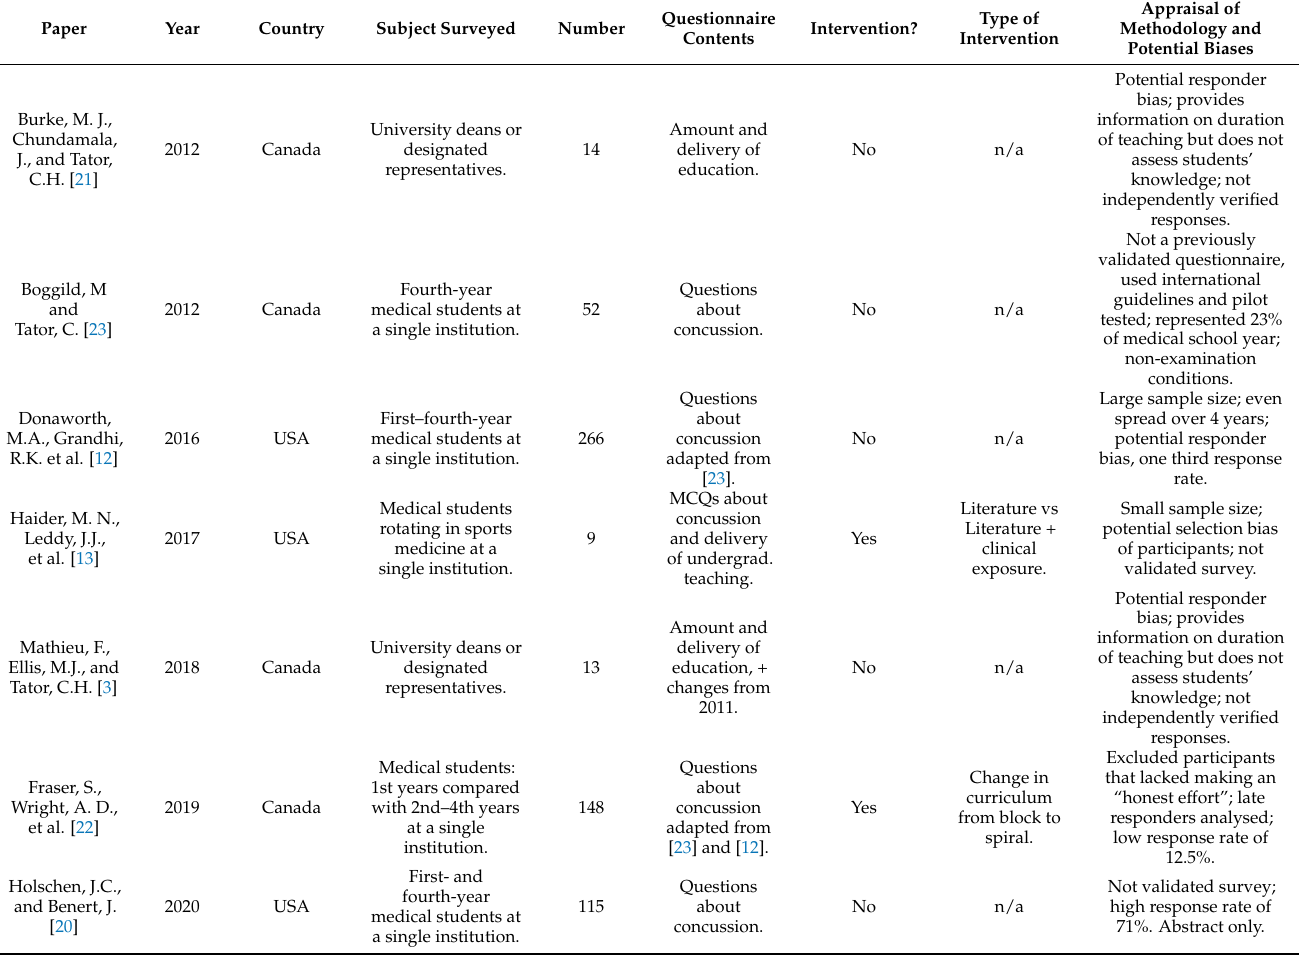
Table 2. The subject of questionnaires in included research